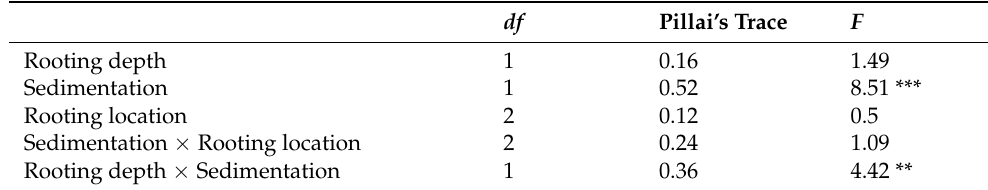
Table 4. MANOVA table of the effects of rooting depth type, sedimentation and rooting location on soil NIR data.